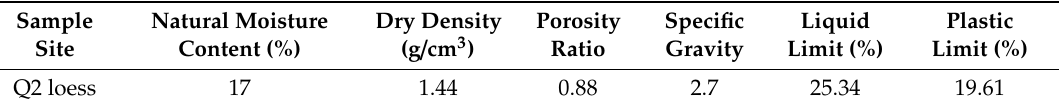
Table 1. Basic physical parameters of Q2 loess samples from a landslide located in the South Jingyang Plateau.